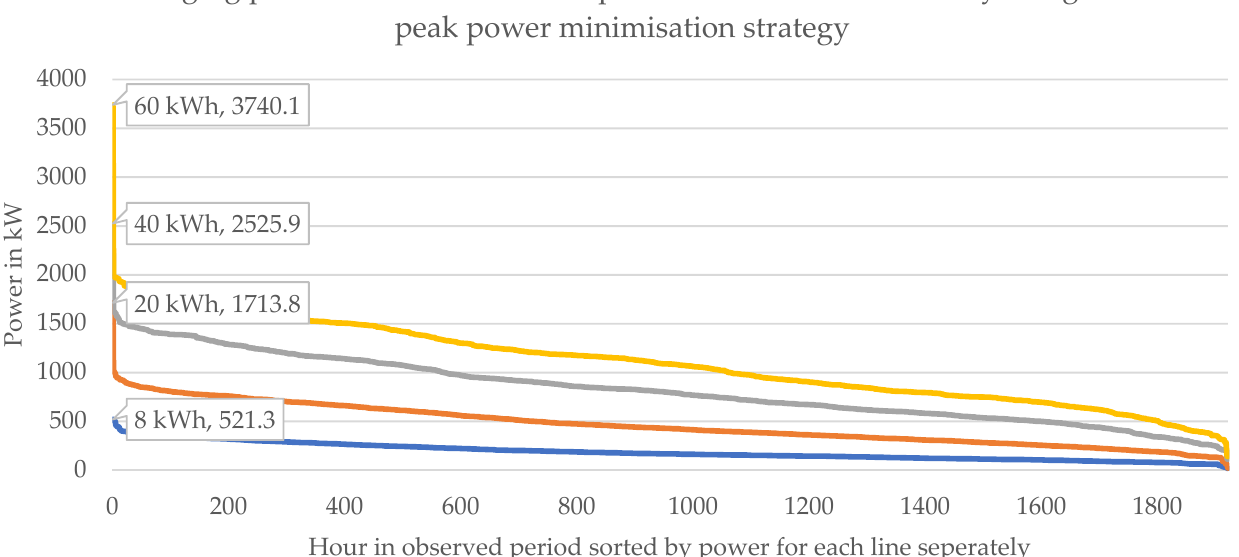
Figure 14. Sorted summed connector power when employing the peak minimization strategy. For example, if during each charging process 40 kWh should be charged, during ~400 h of the observed 1921 h, the chargers consumed 500 kW or less.